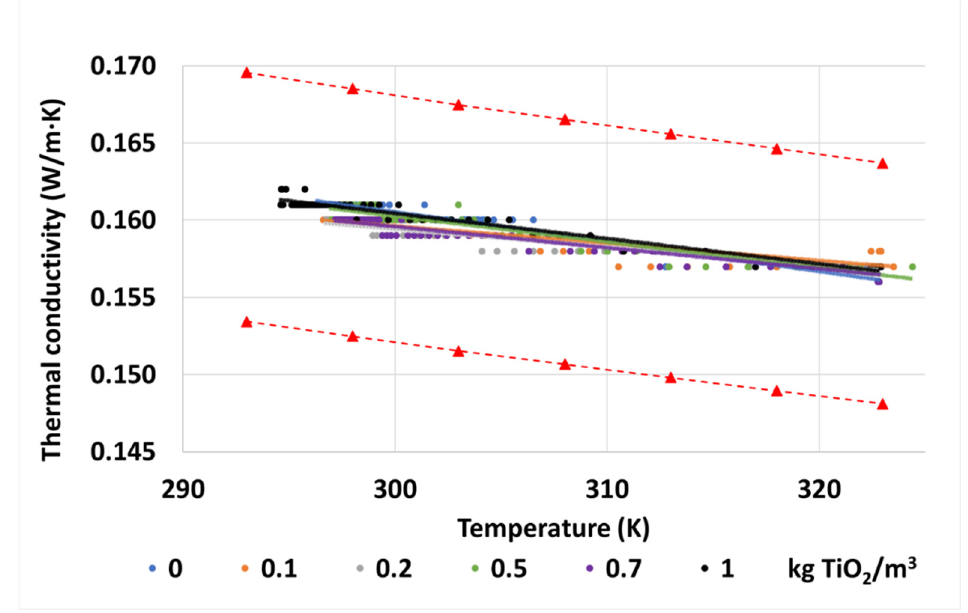
Figure 7. Thermal conductivities of the tested samples of base fluid and TiO 2 nanofluids, including the uncertainty gap of the experiments according to the estimated error of the tester (red dashed lines).